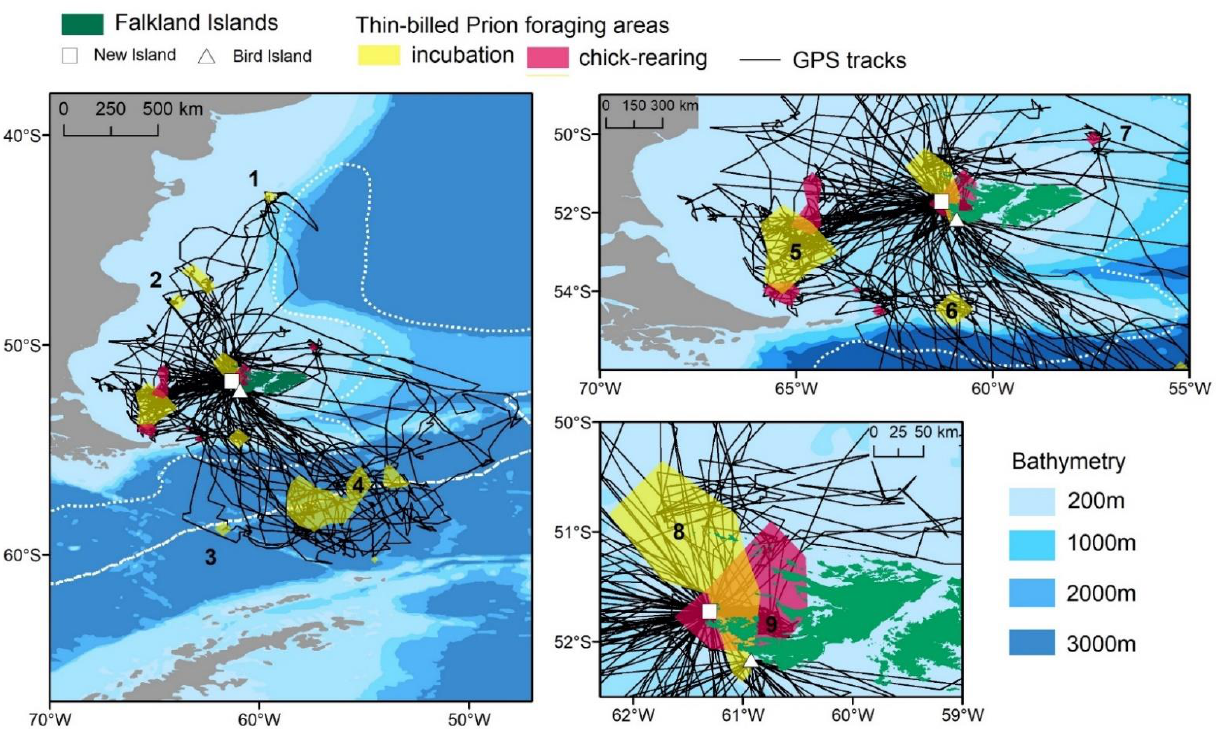
Figure 1. Overview map of tracks and main foraging areas (obtained by kernel analysis) of Thin-billed Prions from two colonies in the Falkland Islands. Table 2. Trip parameters (mean ± SD) of incubation and chick-rearing trips of Thin-billed Prions. Trip parameters were compared using Kruskal-Wallis ANOVA on Ranks (degrees of freedom: df), followed by Dunn tests. Within lines, homogenous sub-groups are given in superscript letters. Range is the maximum distance from the colony. “Short trips” are trips from 1–4 days, while “long trips” lasted 5–11 days.